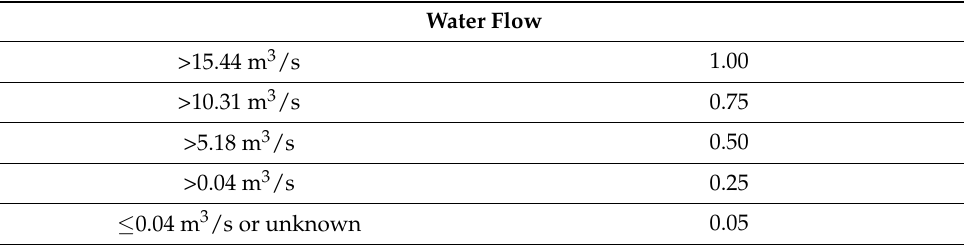
Table 8. Geological–hydrological category “Water flow” with probability